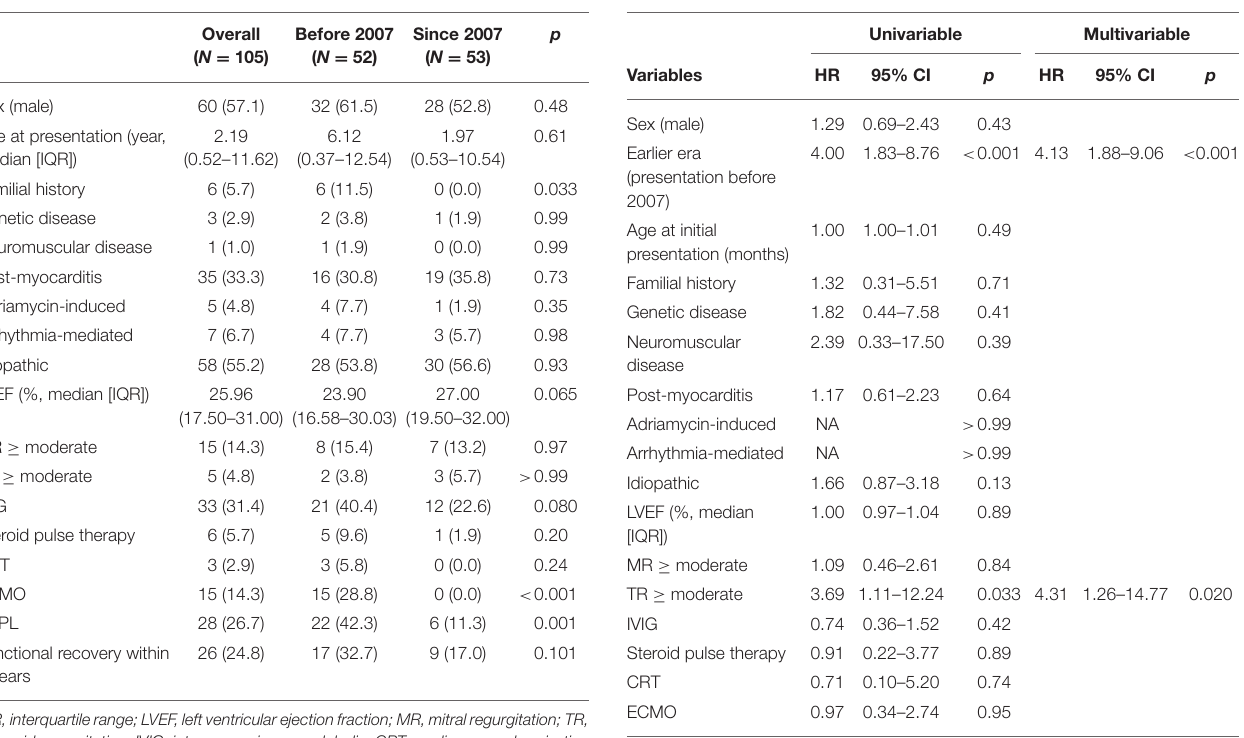
TABLE 1 | Comparison of the patient characteristics between the two eras. TABLE 2 | Risk factors for decreased time to death before heart transplantation.